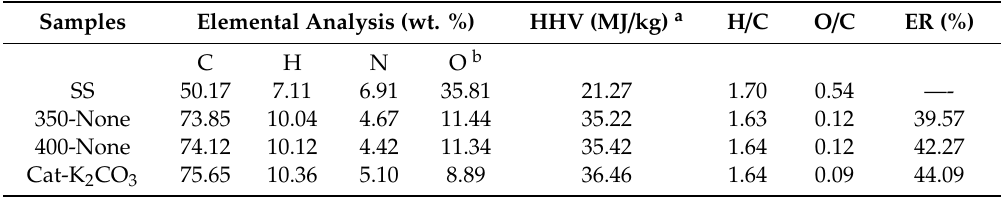
Table 4. The elemental analysis of the bio-crude at sub and supercritical conditions.